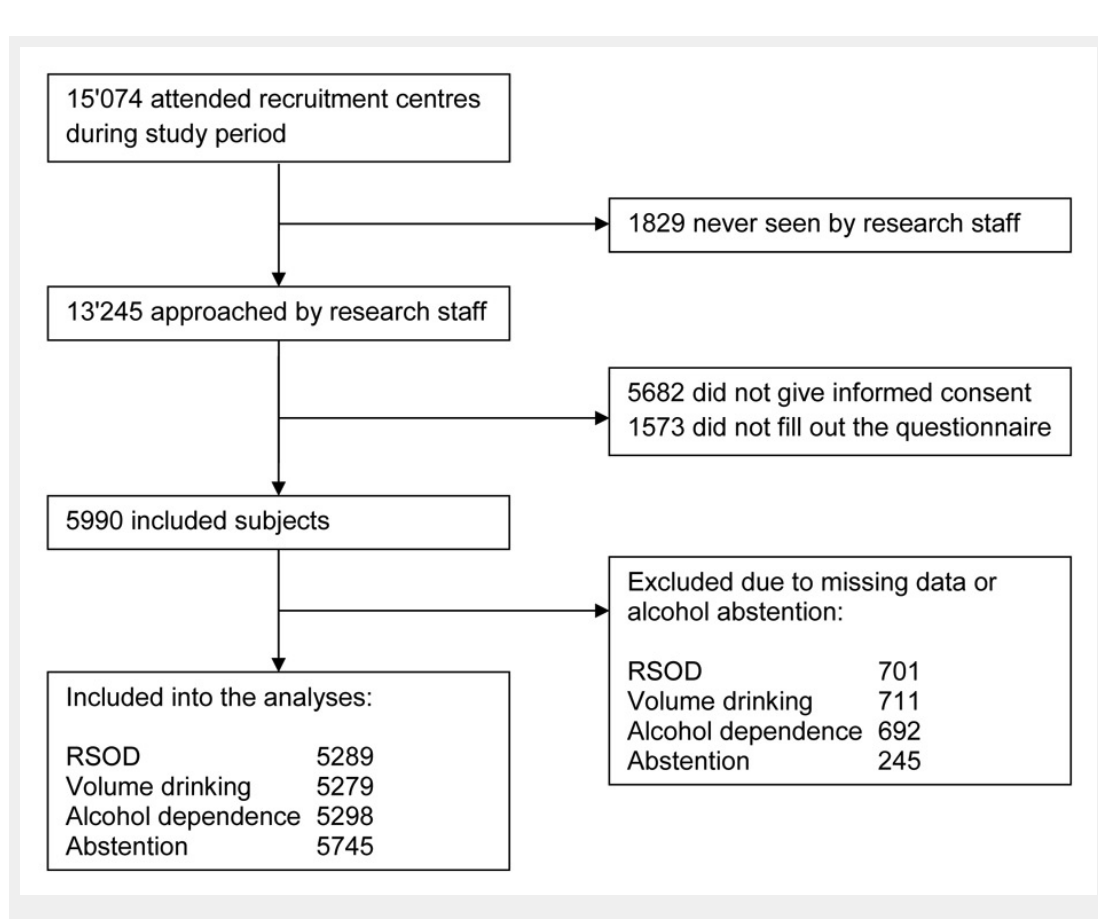
Figure 1 Flow chart of sample